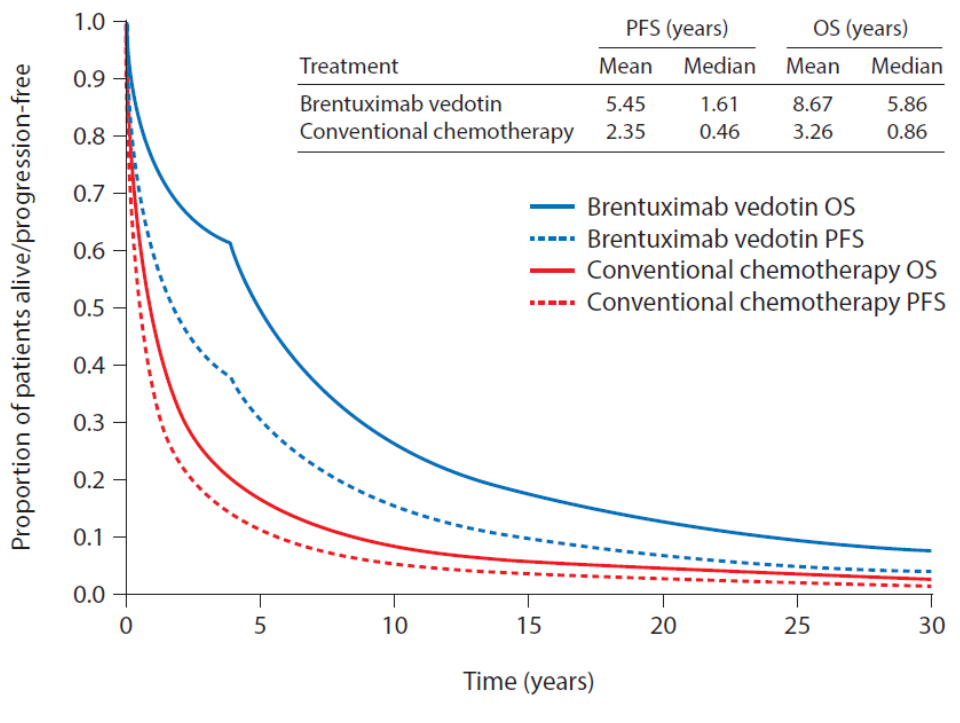
Figure 2. Adjusted Predicted OS and PFS for Brentuximab Vedotin and Conventional